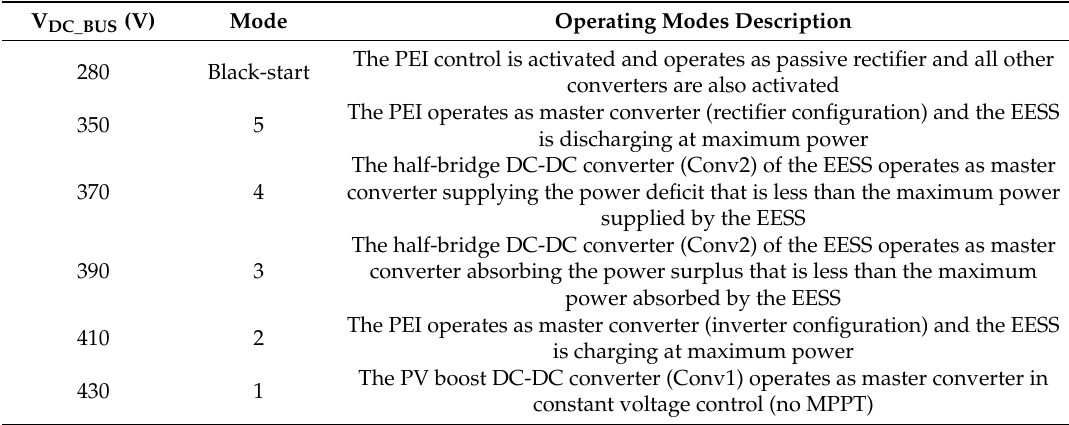
Table 3. DC Bus Signaling (DBS) Logic Voltage